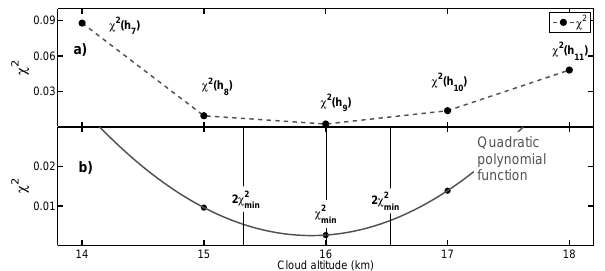
Figure 12. (a) Distribution of χ 2 with the cloud altitude ( h = h n , n = 7 ,..., 11; h 7 = 14km, h 8 = 15km, h 9 = 16km, h 10 = 17km and h 11 = 18km) for a sub-visual cirrus cloud observed on 18 Jan- uary 2005. The distribution of χ 2 with cloud altitude is represented only for five values of cloud altitude of the LUT grid in order to facilitate the interpretation of the figure. (b) Quadratic polyno- mial function (grey solid line) calculated from h 8 , h 9 , h 10 , χ 2 ( h 8 ) , χ 2 ( h 9 ) and χ 2 ( h 10 ) (black dots). The cloud altitudes h ± with χ 2 ( h ± ) = 2 ∗ χ 2 are 15.33 and 16.43km, and hence in this case min the cloud altitude = [16 − 0.67km, 16 +